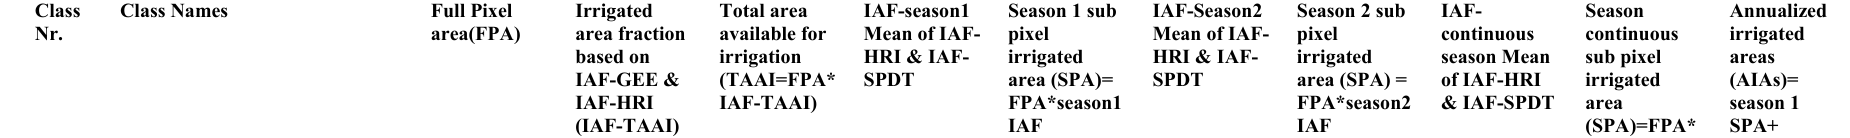
Table 3. Sub-pixel irrigated Areas (SPIAs) computed considering intensity (annualized irrigated areas based on areas of single, double, and continuous crops) and without considering intensity (total area available for irrigation). SPIAs are computed by multiplying irrigated area fractions (IAFs) with full pixel irrigated areas